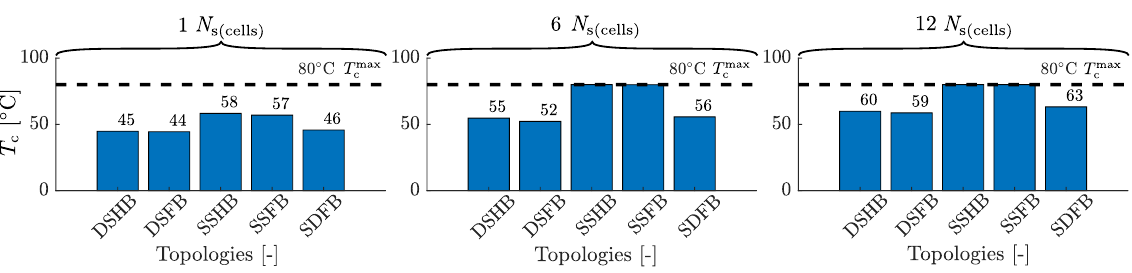
Figure 9. The submodule temperature for all topologies with 1, 6, and 12 N s(cells) at a maximum charging power of P c max